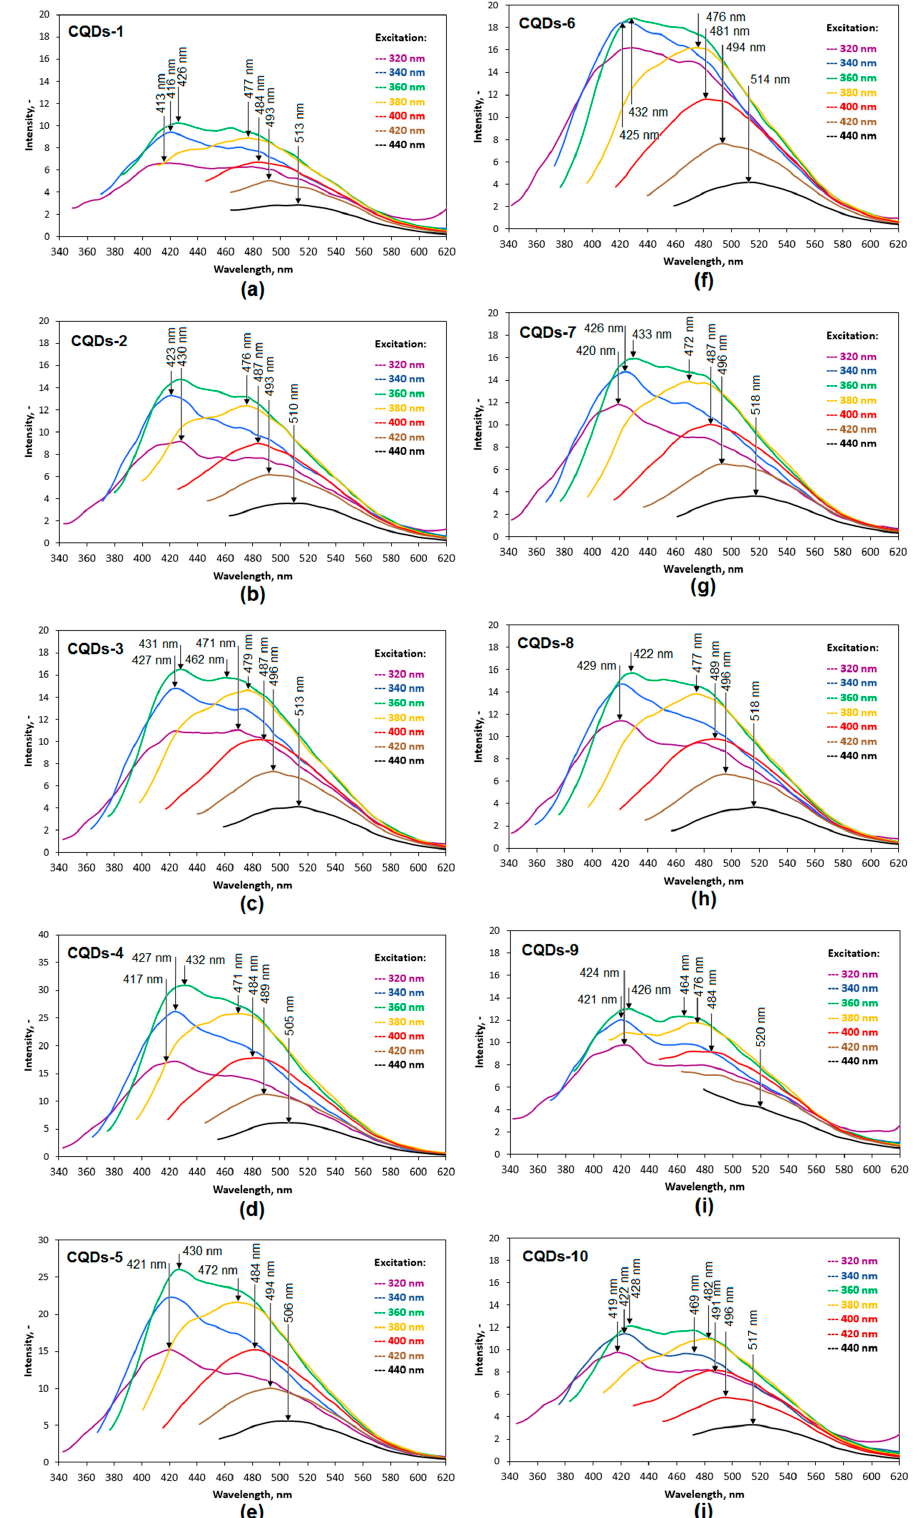
Figure 3. Fluorescence spectra of the prepared carbon quantum dots: ( a ) sample CQDs-1; ( b ) sample CQDs-2; ( c ) sample CQDs-3; ( d ) sample CQDs-4; ( e ) sample CQDs-5; ( f ) sample CQDs-6; ( g ) sample CQDs-7; ( h ) sample CQDs-8; ( i ) sample CQDs-9; ( j ) sample